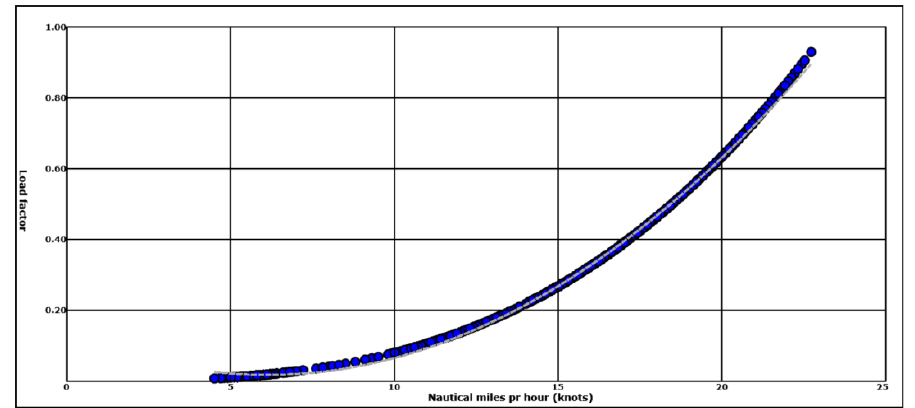
Figure 12. Propulsion fuel use profile for Norwegian Star , May 2016, using Finnmarken data for load and specific fuel consumption. Blue points are estimated kg/nautical mile for different speed values, gray line is fitted second-degree polynomial trend-line.